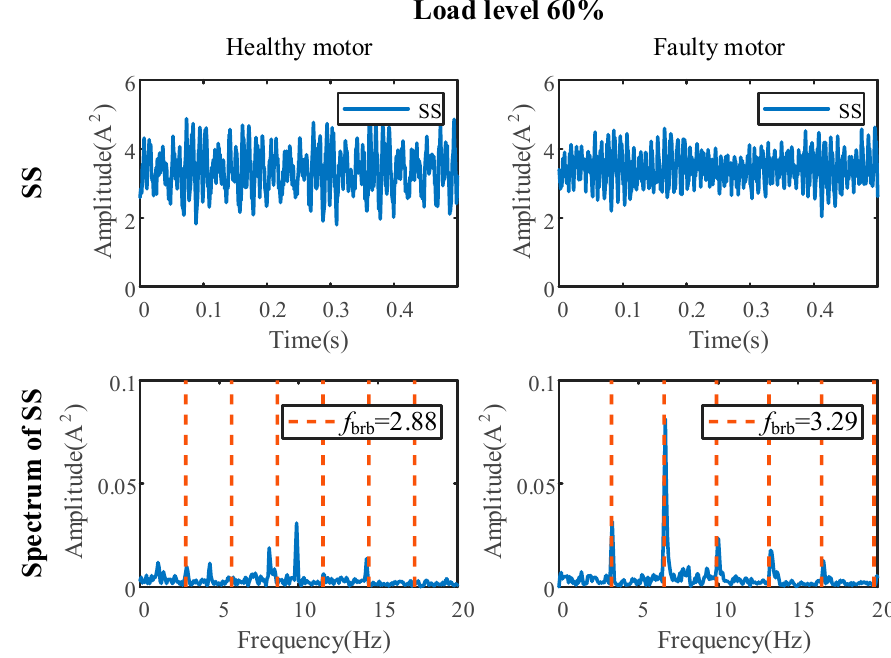
Figure 5. The SS signal and its spectrum of healthy motor and faulty motor at 60% load.